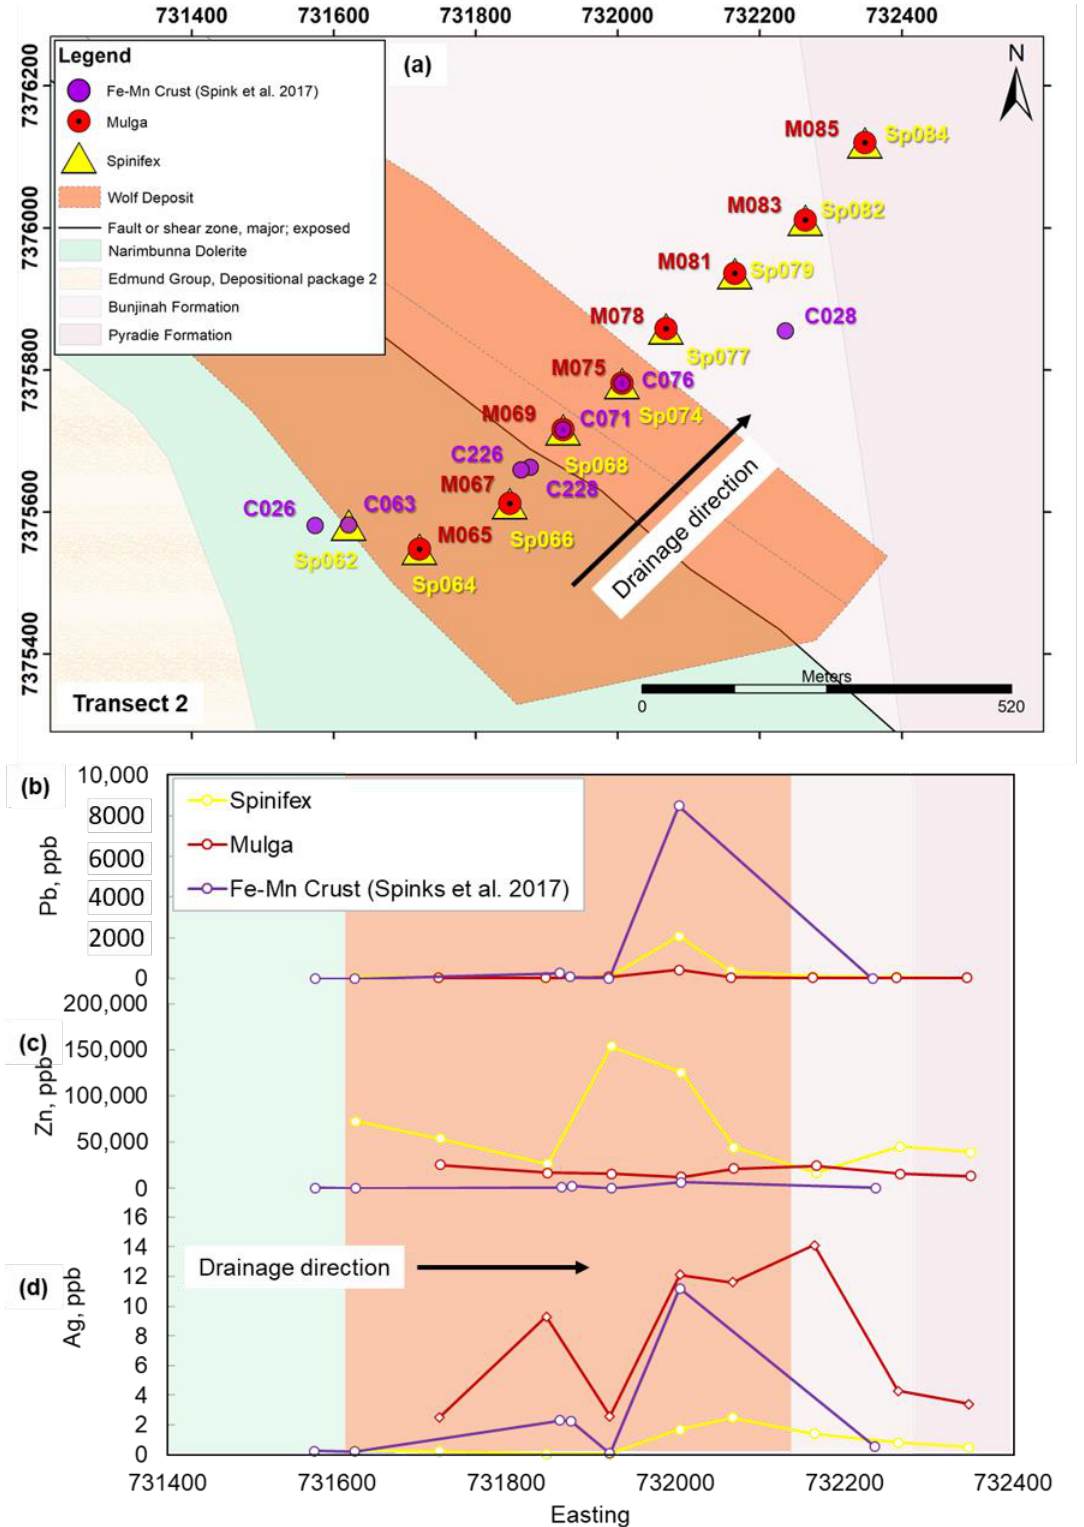
Figure 9. Metal concentrations in mulga, spinifex and Fe–Mn crust samples along transects T2 (Wolf deposit). ( a ) Location of samples along transect T2 over the Wolf deposit. ( b ) Lead concentrations in mulga, spinifex and Fe–Mn crust samples along transect T2. ( c ) Zinc concentrations in mulga, spinifex and Fe–Mn crust samples along transect T2. ( d ) Silver concentrations in mulga, spinifex and Fe – Mn crust samples along transect T2.